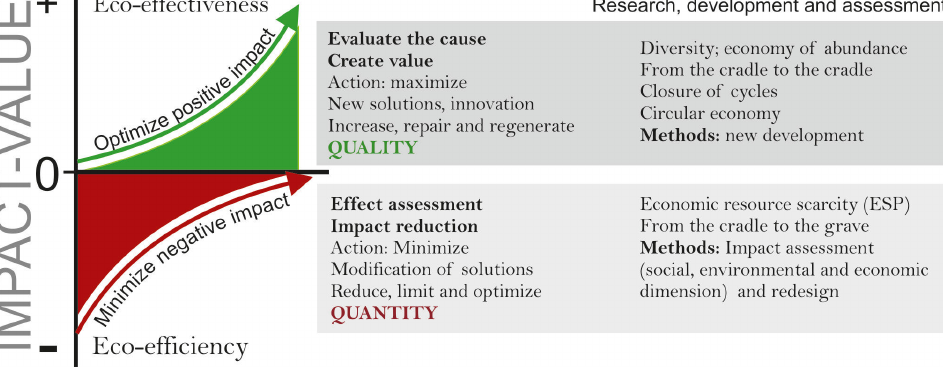
Figure 1. Eco-effectiveness perspective versus eco-efficiency